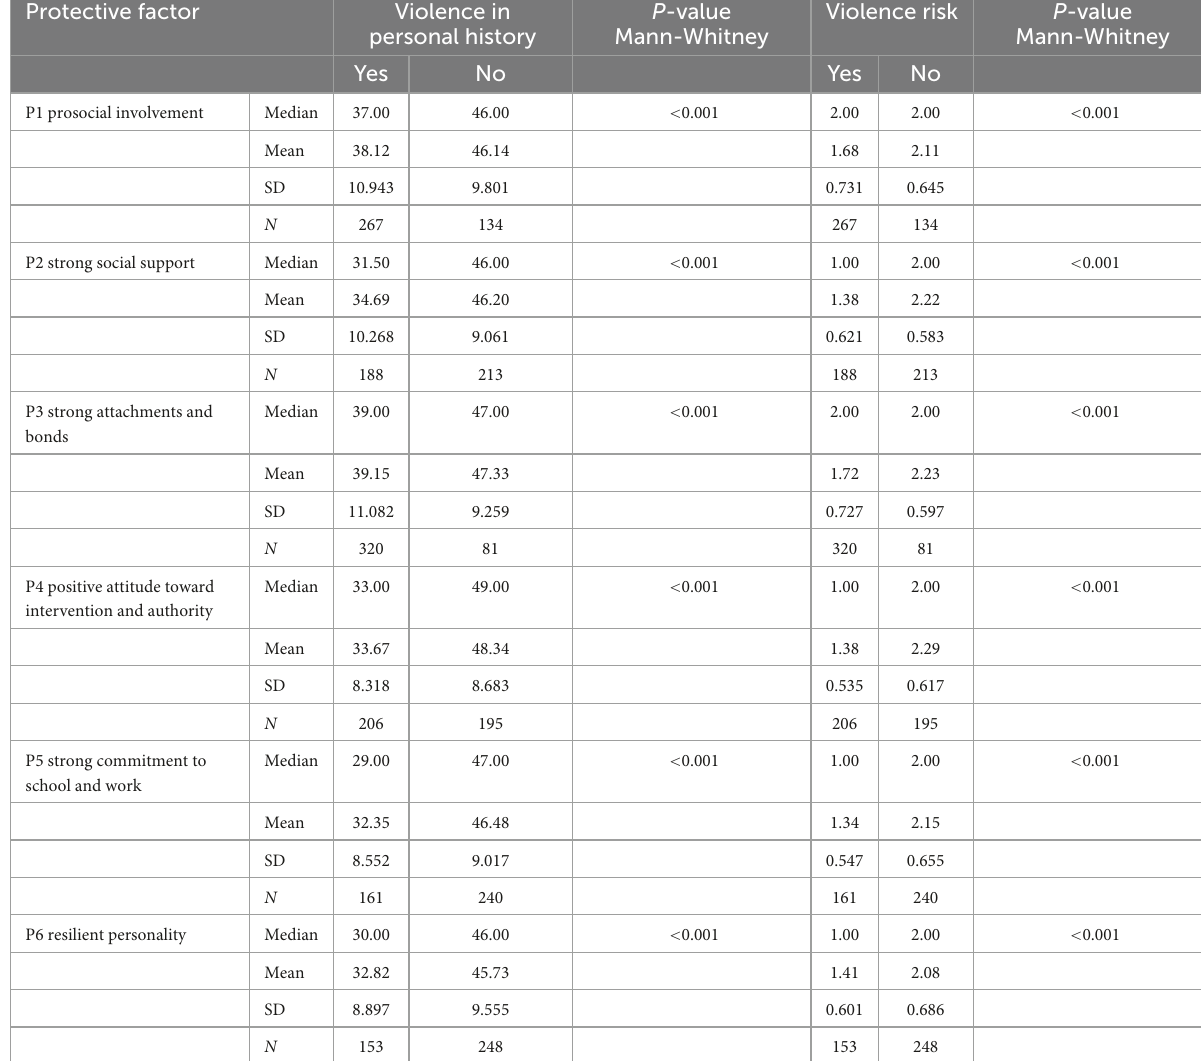
TABLE 3 Violence protective factor prevalence in violent and non-violent adolescents. Protective